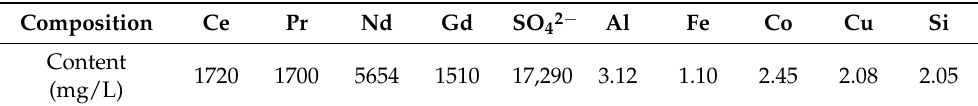
Table 1. The main composition and content of leachate obtained after sulfated roasting followed by a water leaching